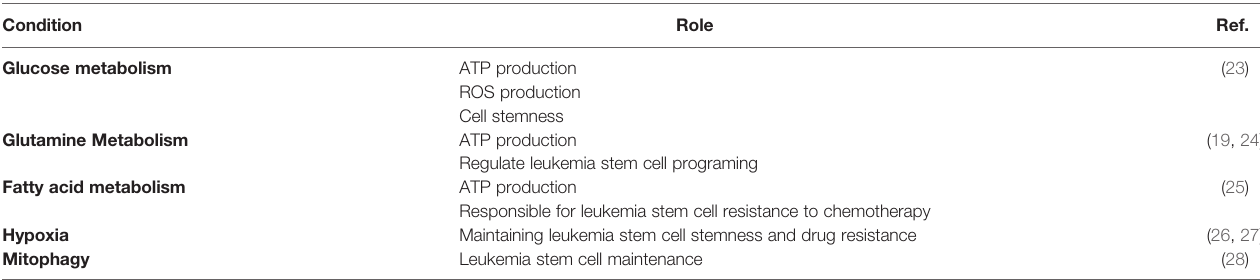
TABLE 1 | Summary of the metabolic steps implicated in the survival and therapy resistance of LSCs.